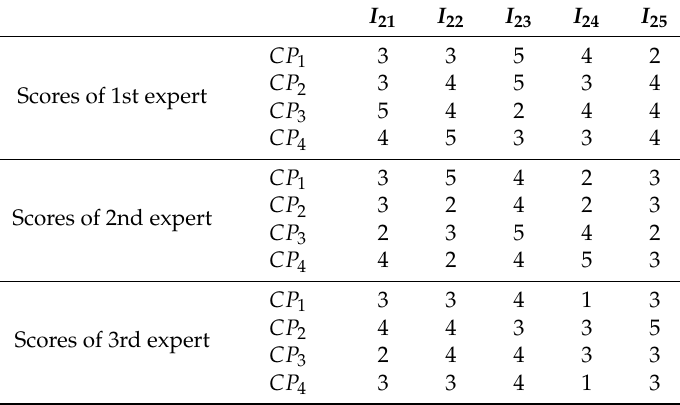
Table A11. Scores of the status level of the planning process